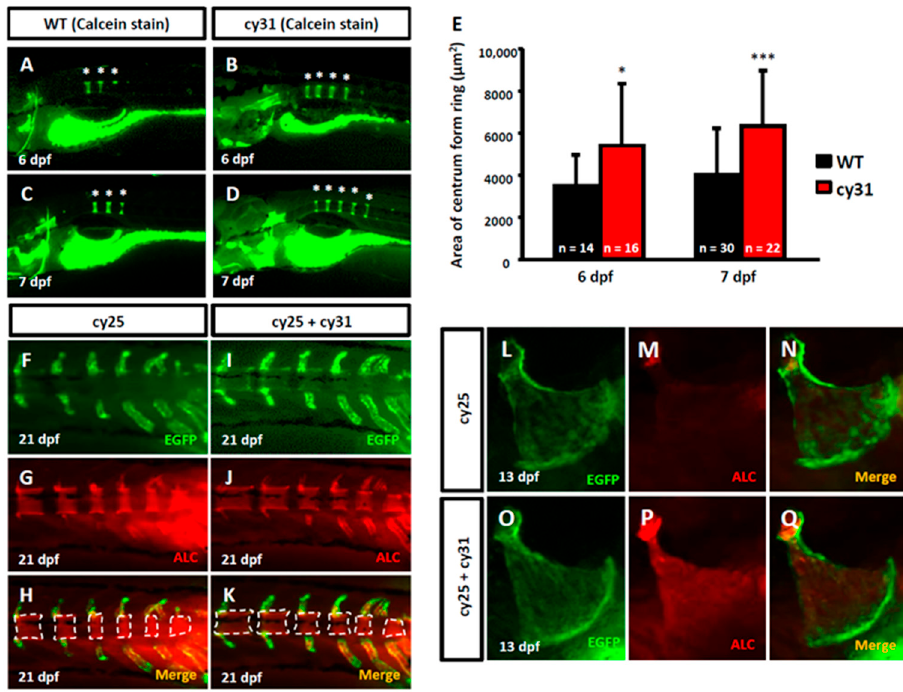
Figure 2. Evaluation of calcification in N1aICD-expressed transgenic zebrafish. ( A – D ) Calcein staining on wild type and Tg(Ola.Sp7:N1aICD) cy31 embryos at 7 days post-fertilization (dpf). The * indicates the formed column. ( E ) Quantification of calcification degree by calculating the area of ring centrum formation in the notochord. N represents the fish number used for analysis. ( F , G , H ) EGFP-expressed osteoblasts in green fluorescence, alizarin complexone (ALC) staining region and merged image in notochord of Tg(Ola.Sp7:EGFP) cy25 transgenic fish aged at 21 dpf. ( I , J , K ) N1aICD-expressed osteoblasts in green fluorescence, ALC staining region and merged image in notochord of double transgenic fish of Tg(Ola.Sp7:EGFP) cy25 and Tg(Ola.Sp7:N1aICD) cy31 at 21 dpf. The dashed line surrounded areas were measured using image quantitation and summed up for comparison. ( L , M , N ) EGFP-expressed osteoblasts in green fluorescence, ALC staining region and merged image in opercula of Tg(Ola.Sp7:EGFP) cy25 at 13 dpf. ( O , P , Q ) N1aICD-expressed osteoblasts in green fluorescence, ALC staining region and merged image in opercula of Tg(Ola.Sp7:EGFP) cy25 and Tg(Ola.Sp7:N1aICD) cy31 double transgenic fish at 13 dpf (averages ± SD; * p < 0.05; *** p < 0.005; n = fish number).